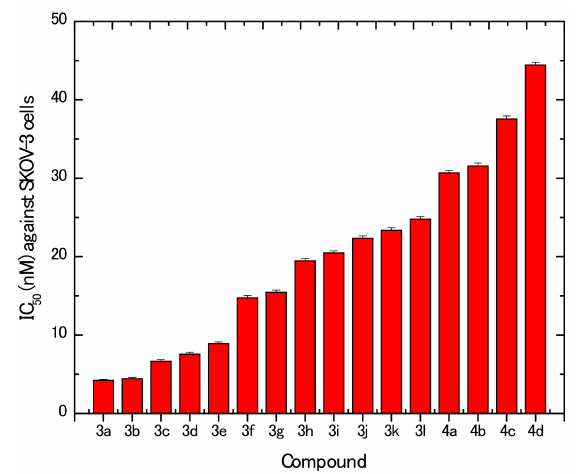
Figure 1. In vitro Cytotoxicity activities of the tested compounds against SKOV-3 cells.